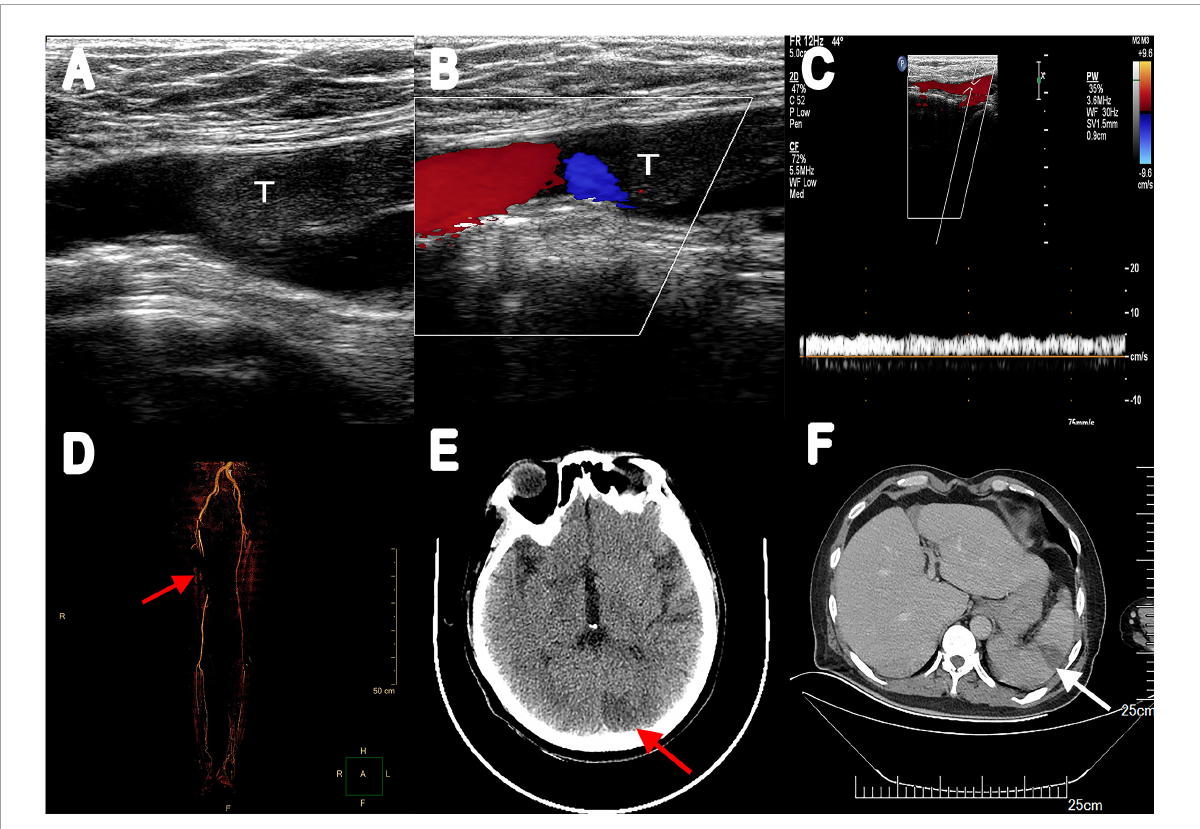
FIGURE2 (A) Vascular ultrasonography showed hypoechoic filling echo was seen at the distal end of the right common femoral artery. (B) Color Doppler image displayed there was little color blood flow signal. (C) Abnormal spectrum morphology of posterior tibial artery with the significantly reduced blood flow velocity. (D) Multiple filling defects of the right femoral artery were observed in three-dimensional reconstruction (red arrow). (E) Enhanced CT scanning revealed a low-density lesion in the left occipital lobe (red arrow). (F) Abdominal enhancement CT showed wedge-shaped hypodense lesions under the capsule with no enhancement (white arrow). T,